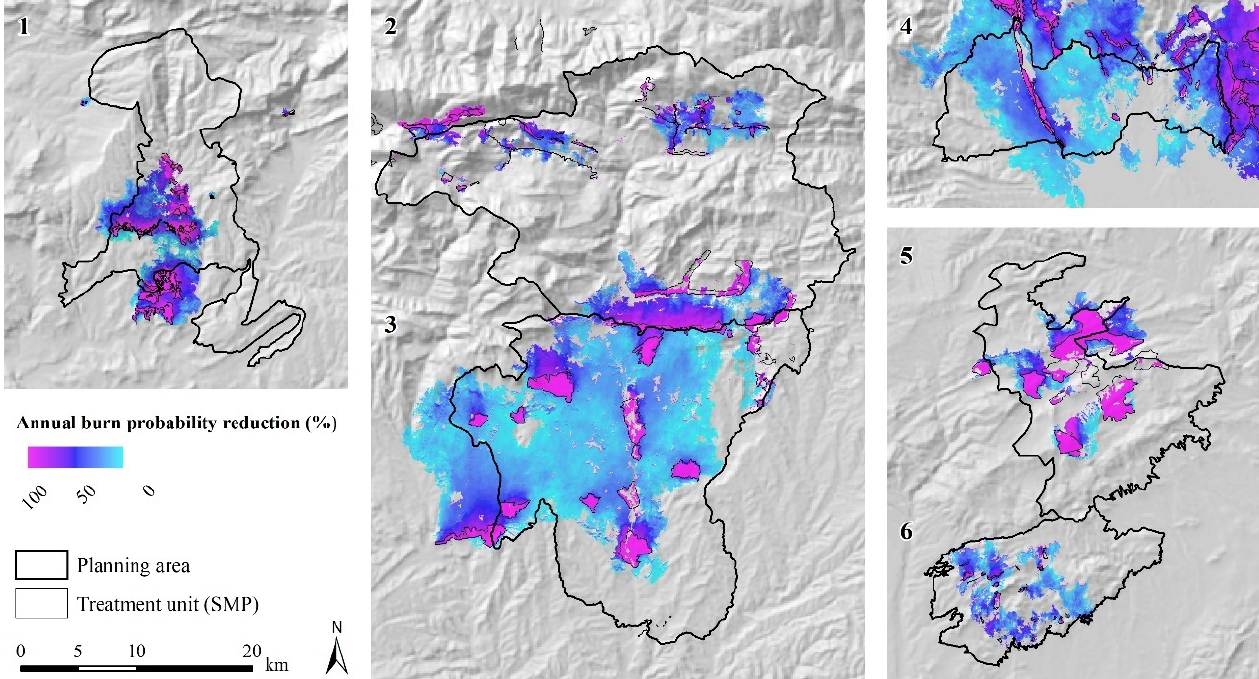
Figure 6. Spatially explicit reduction in the annual burn probability, as a percentage, due to the implementation of treatments